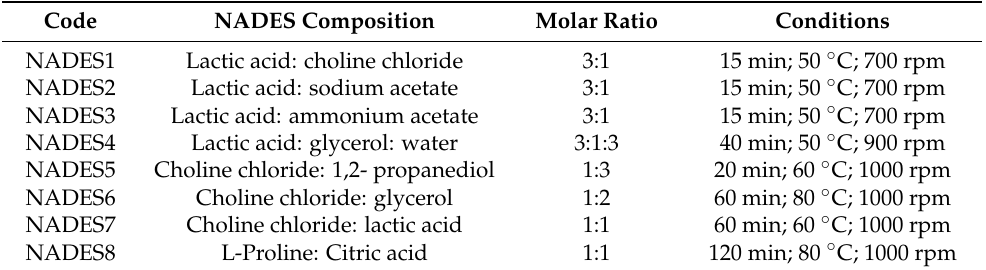
Table 4. Composition of the natural deep eutectic solvents (NADES) used in the present